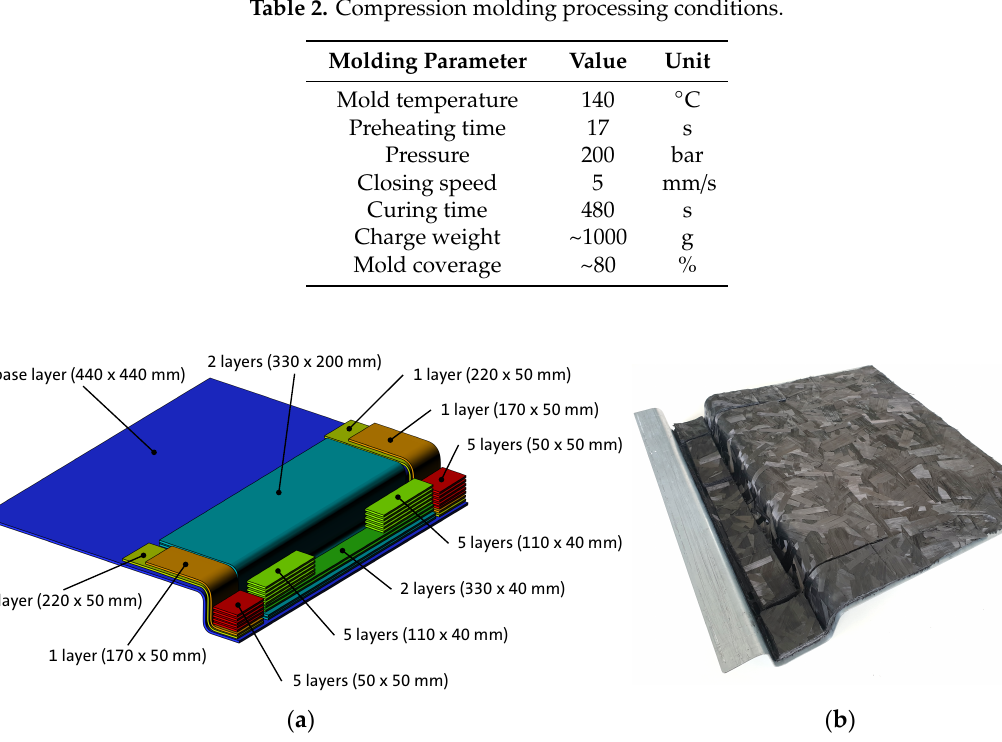
Figure 5. HexMC charge pattern for ribbed structure part; ( a ) schematic illustration with dimensions and number of layers per charge package (for visualization purposes the charge package are slightly separated in thickness direction); ( b ) prepared HexMC charge on a metal preform.